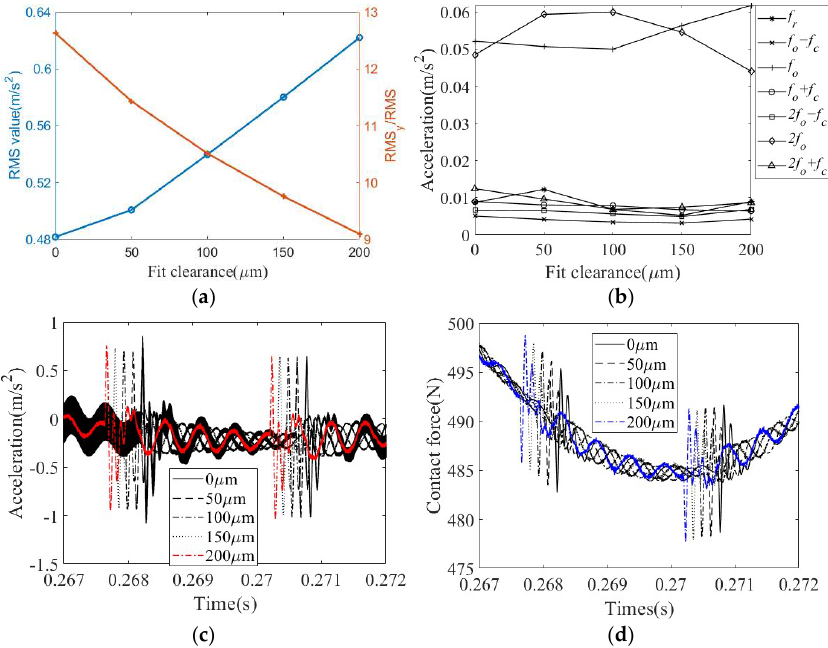
Figure 17. The vibration characteristics of the bearing under outer ring defect and fit clearance: ( a ) RMS and RMS y /RMS; ( b ) amplitudes of f r , f o − f c , f o , f o + f c , 2 f o − f c , 2 f o , 2 f o + f c ; ( c ) housing acceleration signal from 0.267 s to 0.272 s; ( d ) contact force between outer ring and housing from 0.267 s to 0.272